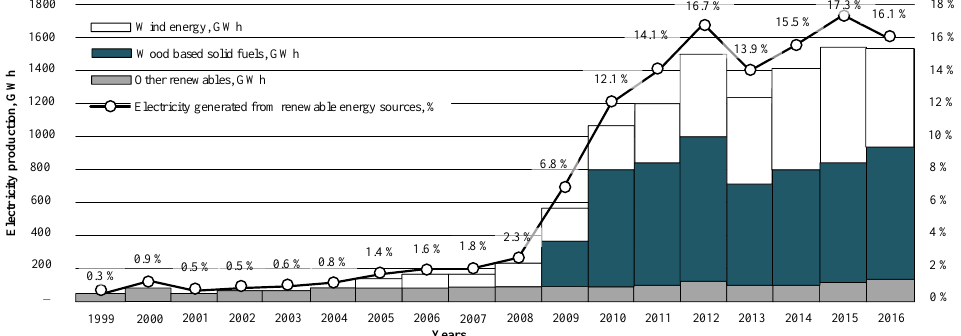
Fig. 2. Share of electricity generated from renewable fuel, and amount of electricity produced from renewable energy sources out of gross power consumption in Estonia. It should be noted that, in accordance with the Electricity Market Act definition, biomass cogeneration process estimations vary from the efficient cogeneration process calculations. The key points of dissimilarity between the biomass CHP process and the efficient